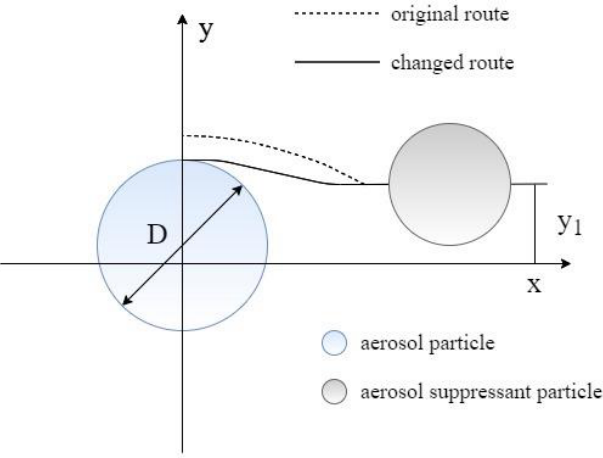
Figure 7. Aerosol particle captured by an aerosol-suppressant particle.